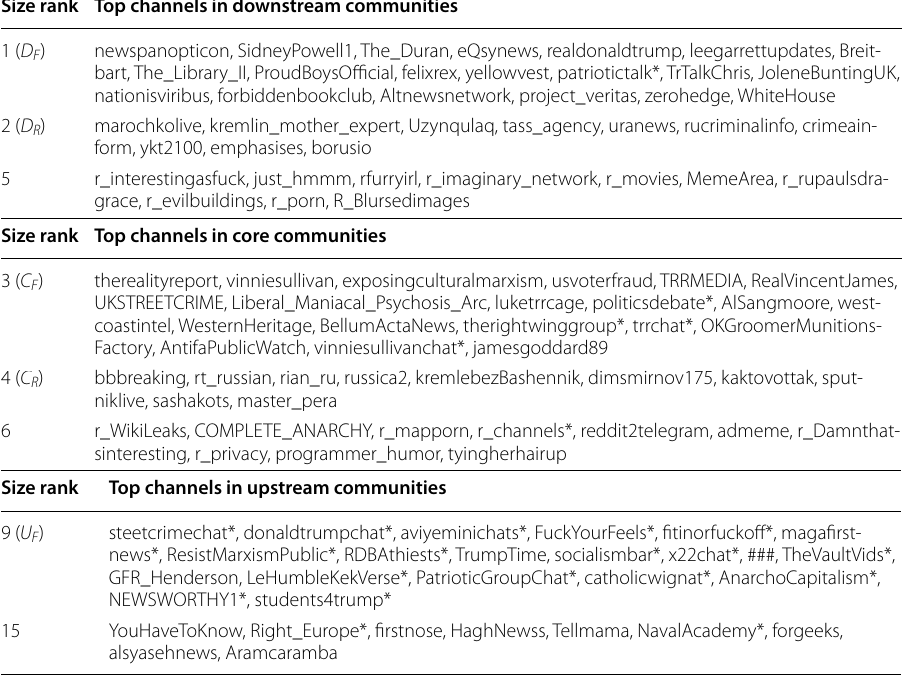
We give the top channels ranked by their in‑Katz centrality for channels in the downstream and core clusters and ranked by their out‑Katz centrality in the upstream clusters. We show the top 20 channels, sorted according to their Katz score, in communities linked to the UK and US far‑right and the top 10 channels in other communities. Channels marked with an asterisk correspond to group chats while the other ones correspond to broadcast channels